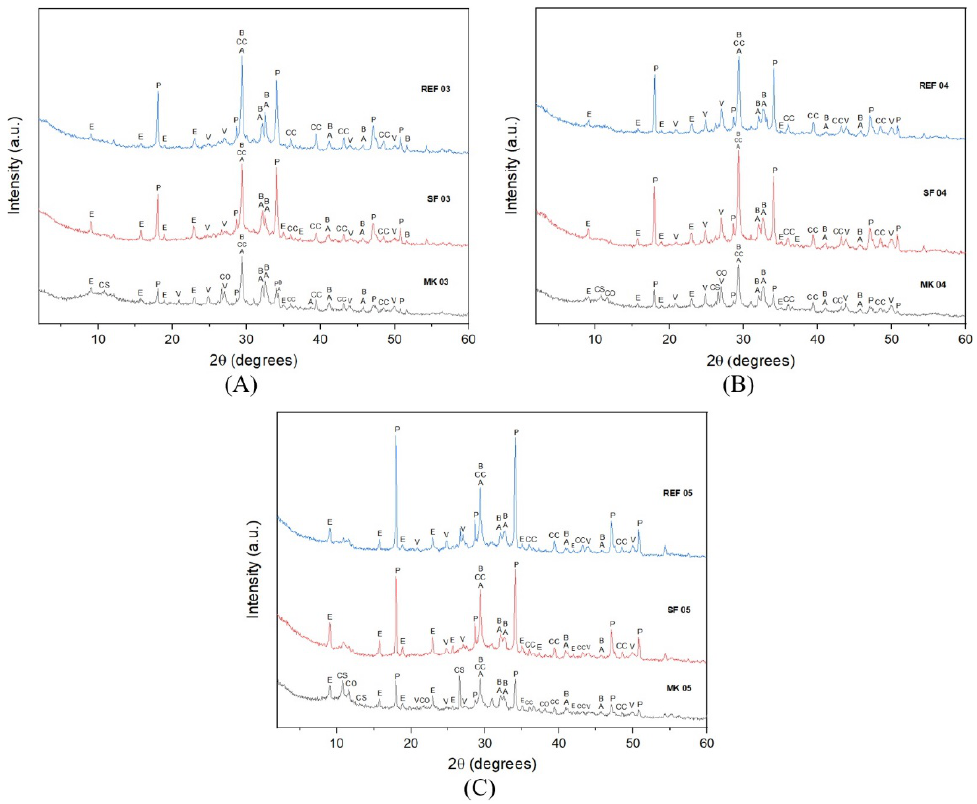
Figure 9. Diffractograms of the cement pastes without supplementary cementitious materials (REF), with the replacement of Portland cement by 10% of silica fume (SF) and with the replacement of Portland cement by 20% of metakaolin (MK), with 28 days of hydration for water/binder ratio of 0.3 (A), 0.4 (B), and 0.5 (C). E- Ettringite, P-portlandite, V-vaterite, A-alite,